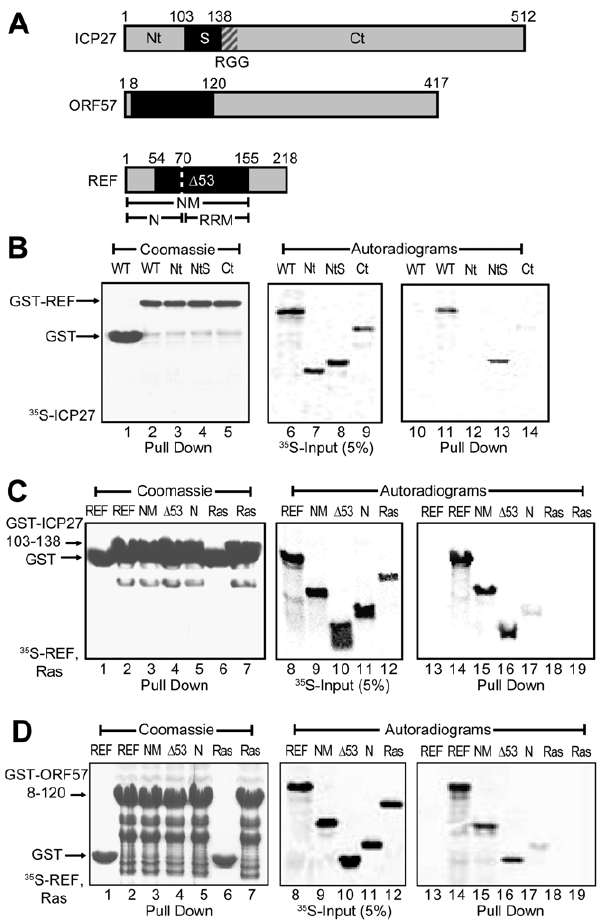
Figure 1. Identification of regions for the interactions between REF and ICP27/ORF57. ( A ) Subdivision of ICP27, ORF57 and REF2-I